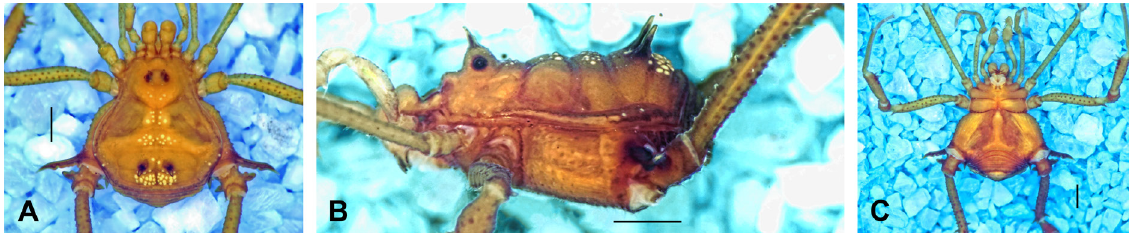
dorsal view. B . Same, lateral view. C . Same, ventral view. Scale bars = 1